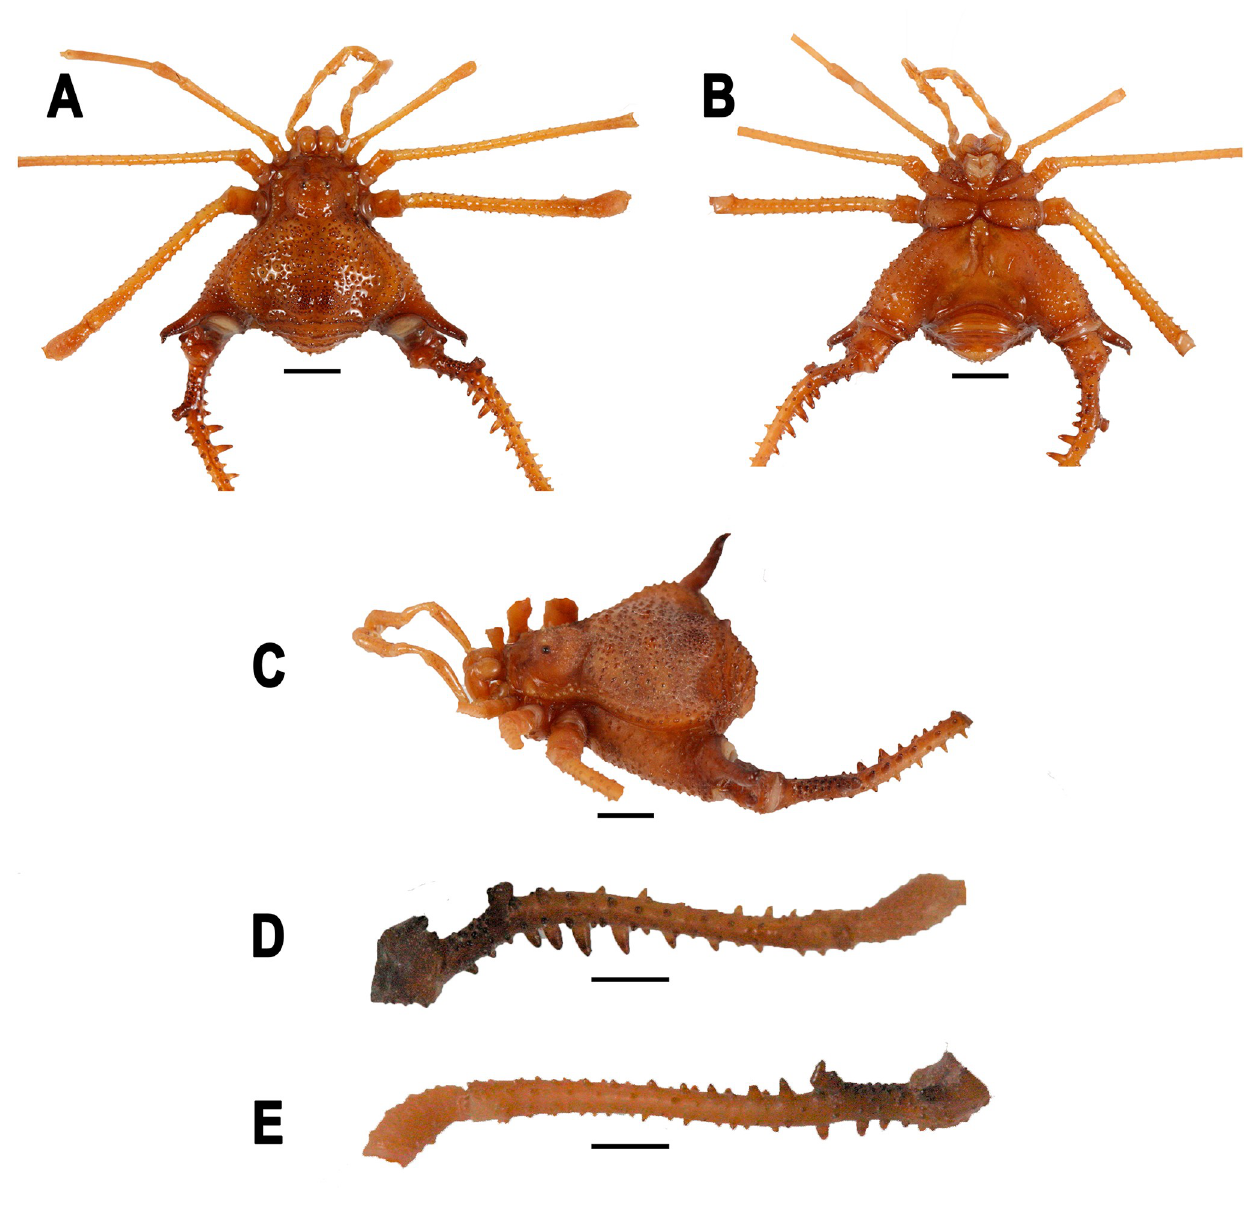
Fig 4. Neosadocus bufo ( “Bunoweyhia” variabilis male lectotype, MNRJ 41803). A. Dorsal view. B. Ventral view. C. Left lateral view. D–E. Right trochanter–patella IV (D: retrodorsal view; E: prolateral view). Scale bar: 3 mm.